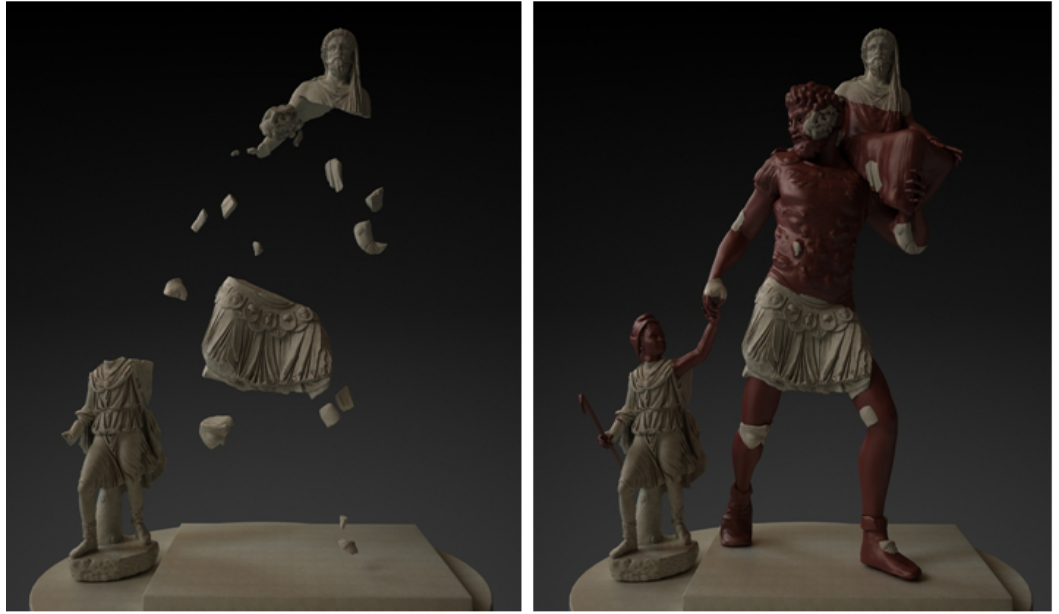
Figure 1. Virtual restitution proposed in Section 4.1. Left: Placement of the 30 recovered fragments. Right: the fragments in their proposed position integrated on a virtual model of the